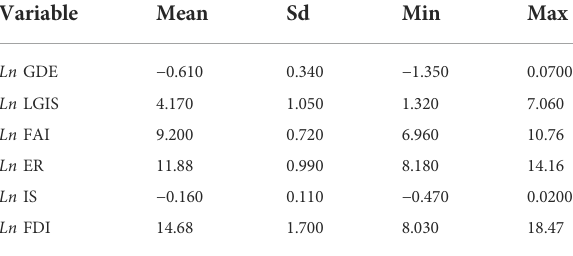
Abbreviations: LGIS, local government innovation support; FAI, provincial fi xed asset investment;ER,totalinvestmentinindustrialpollutioncontrol;IS,theproportionofthe secondary and tertiary industries in the regional GDP.